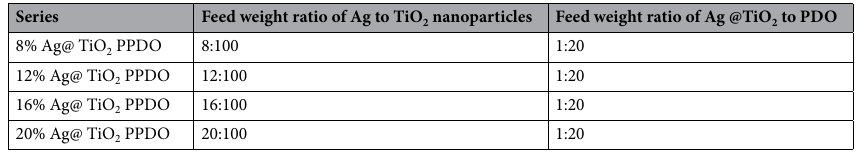
Table 1. Series of Ag@TiO 2